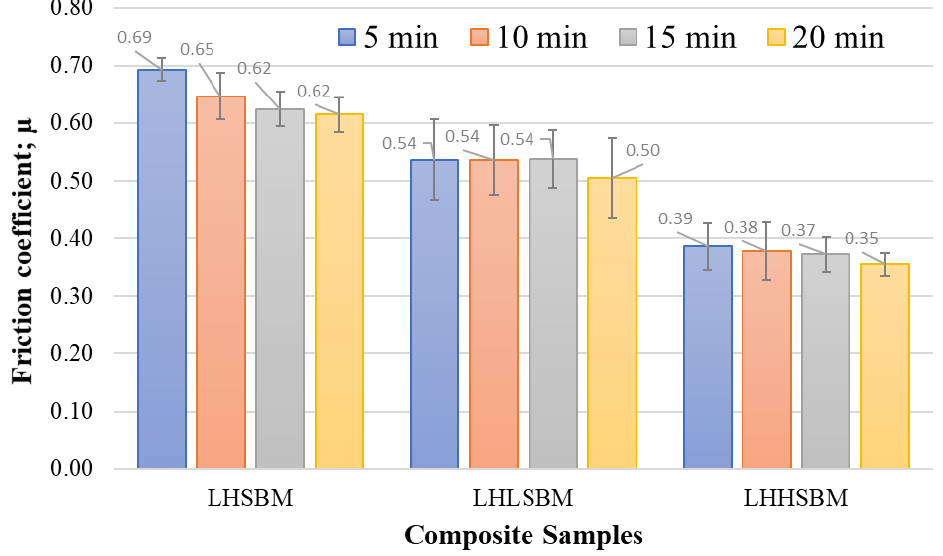
Figure 16. The friction coefficient of Al/SiC composites with different sliding times.